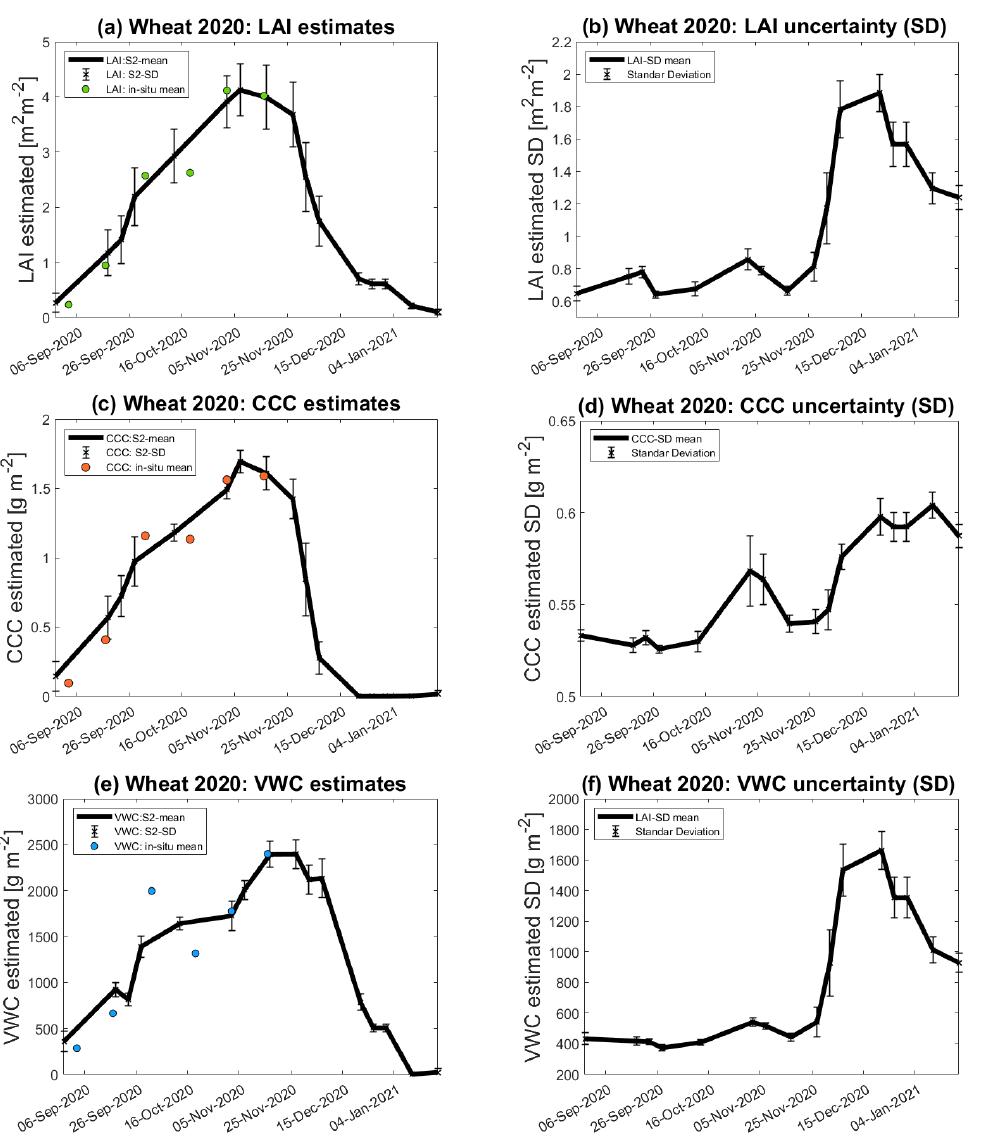
Figure 10. Seasonal evolution of wheat cropland over the three paddocks at the BVCR study sites described by LAI, CCC, and VWC mean values of nice ESUs within the crop limits and the associated uncertainty, plotted as vertical bars. ( a ) LAI estimates; ( b ) LAI uncertainty (SD); ( c ) CCC estimates; ( d ) CCC uncertainty (SD); ( e ) VWC estimates; ( f ) VWC uncertainty